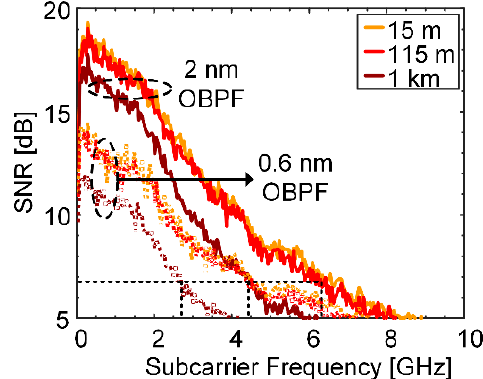
Figure 6. Measured SNR comparison of self-seeded RSOA-FCL transmitter with WDM filter bandwidths of 0.6 and 2 nm in RN. The dotted and solid lines show the measured SNR for the 0.6 and 2 nm filters, respectively. For both cases, three different cavity lengths, 15 m, 115 m and 1 km were used. 0.6 nm filter cavity has peak SNR which is ~5 dB lower than that of the 2 nm one. Table 1. Summary of results to compare the peak signal-to-noise ratio (SNR) and usable SNR bandwidth for the RSOA-FCL (reflective semiconductor optical amplifier fiber cavity laser) with 0.6 nm or 2 nm filter bandwidths. For both filters, the fiber cavity length varied between 15 m, 115 m and 1 km. OBPF: optical band-pass